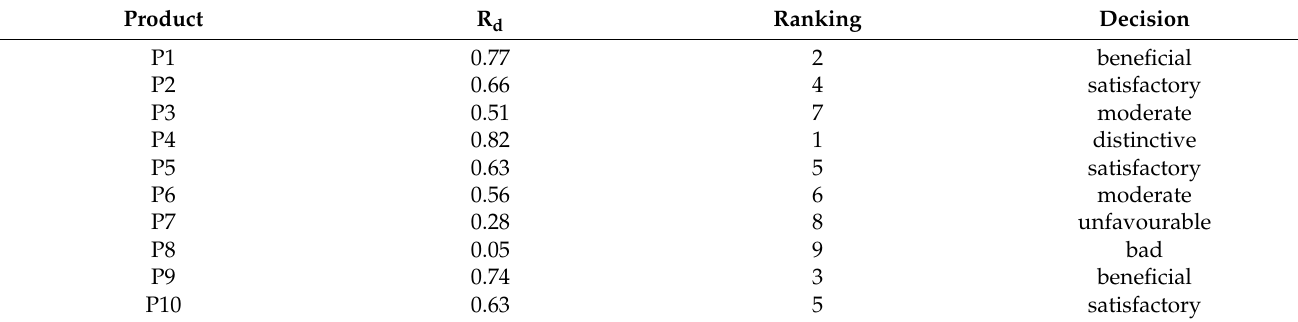
Table 11. Customer satisfaction from qualitative ‐ cost indicator of photovoltaic panels.